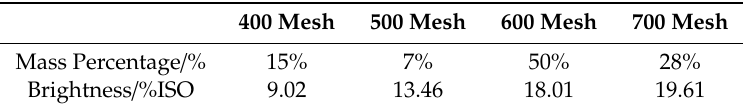
Table 3. Screening analysis of original fly